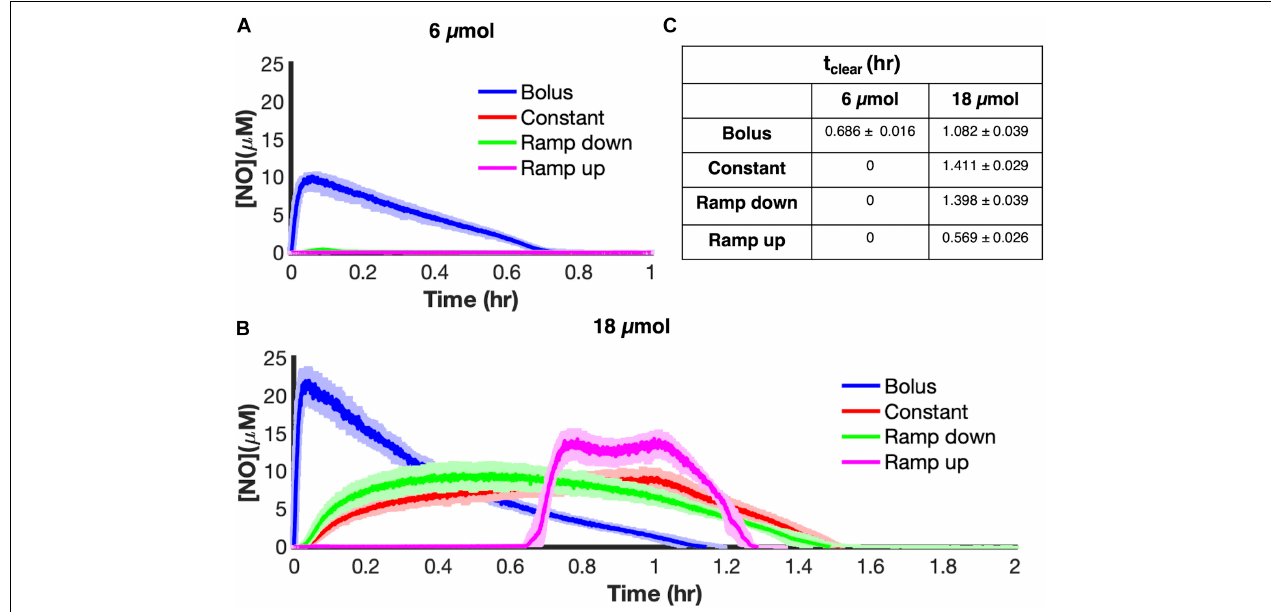
FIGURE 2 | Delivery outcome is payload dependent. E. coli cultures were grown to exponential phase and inoculated in a bioreactor at an OD 600 of 0.05. Five minutes after inoculation, PAPA NONOate was delivered over an hour in one of four ways (bolus-blue; constant-red; ramp down-green; ramp up-pink) at payloads of (A) 6 µ mol or (B) 18 µ mol. [NO] was measured continuously using an ISO-NOP probe. Solid lines represent the mean of three independent experiments, whereas the lightly shaded areas represent the standard error of the mean. (C) The duration of nitrosative stress (t clear ) was measured at 6 µ mol and 18 µ mol for each delivery scheme (calculated as the time for which [NO] ≥ 0.5 µ M). Values represent the average value ± the standard error of the mean.